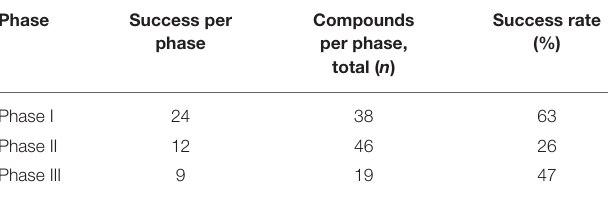
TABLE 3 | Success rates for new compounds in glaucoma clinical trials 2000–2020.